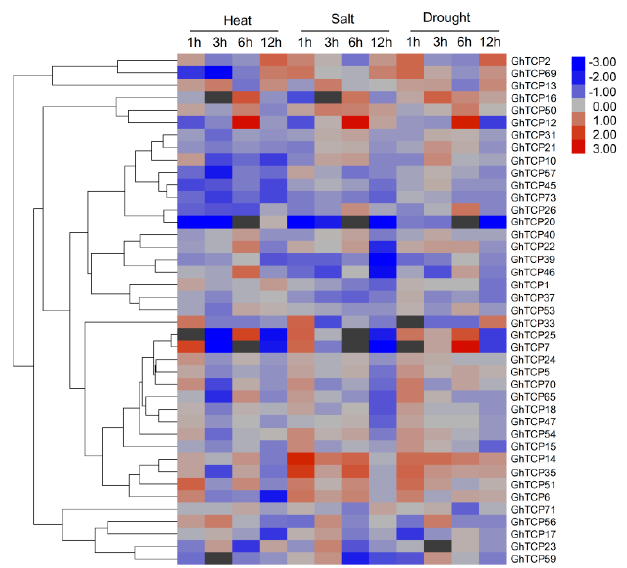
Figure 4. Expression of GhTCP genes under heat, salt, and drought stresses. The genes are shown on the left of the expression bars and the phylogenetic relationship is shown. The abiotic stresses used for expression profiling are indicated at the top. The 1, 3, 6, and 12 h indicate hours after treatment.